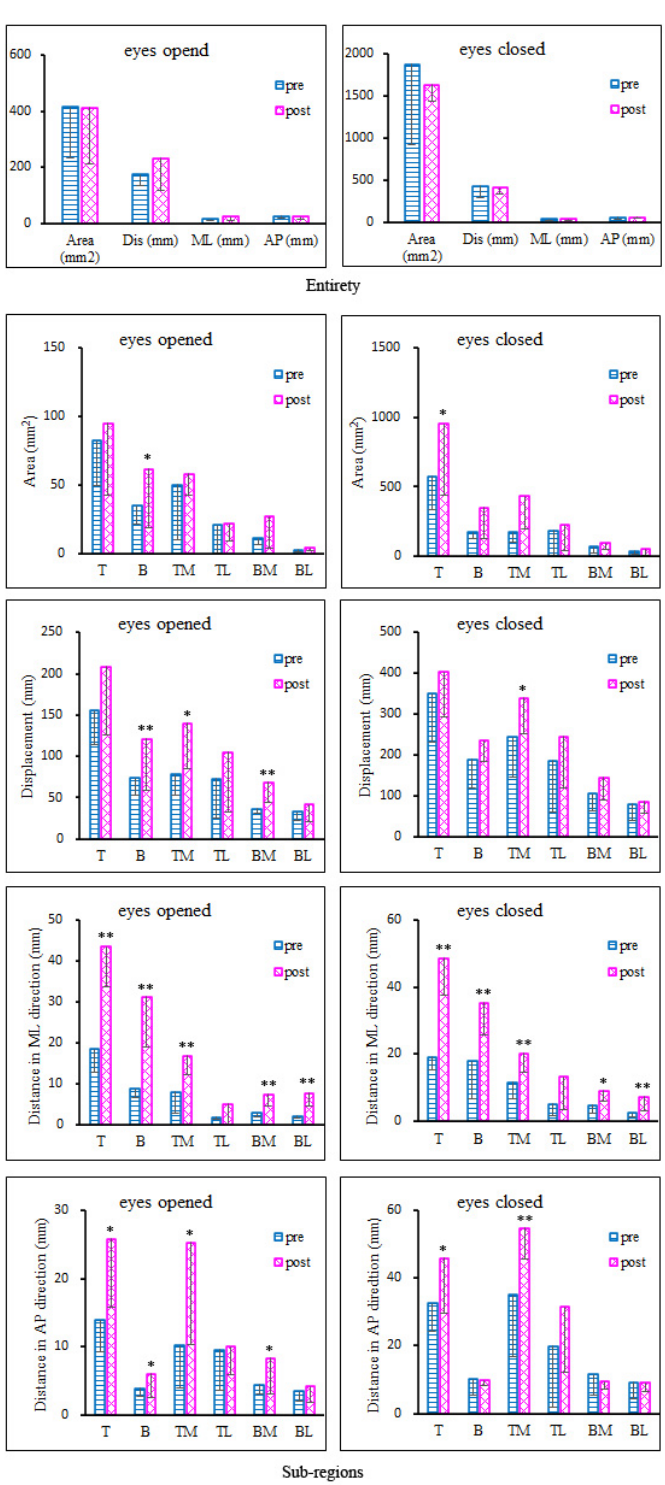
Figure 4. Standing on the dominant leg with eyes opened and closed. Plantar was divided into the following six sub-regions: top (T, forefoot), bottom (B, rearfoot), medial and lateral of the top (TM, TL) and medial and lateral of the bottom (BM, BL). The area (mm 2 ), displacement (mm), sway distance in medial–lateral (ML) and anterior–posterior (AP) regions of postural sway are shown for the entirety and sub-regions using the pre- and post-fatigue protocols. * indicates the significance level p < 0.05; ** indicates the significance level p <